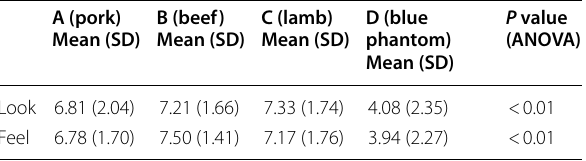
SD standard deviation, ANOVA analysis of